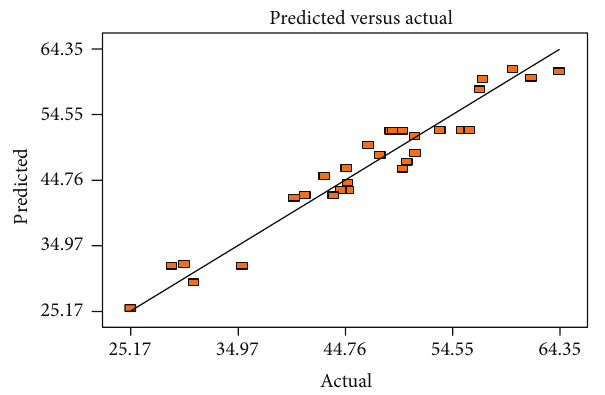
Figure 7: Plot of predicted versus actual TOC removal.